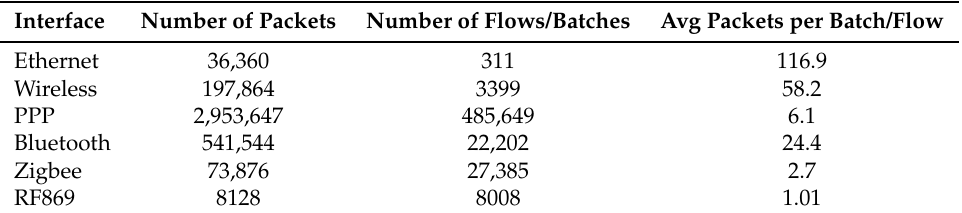
Table 3. Numbers of packets/flows/batches per interface.